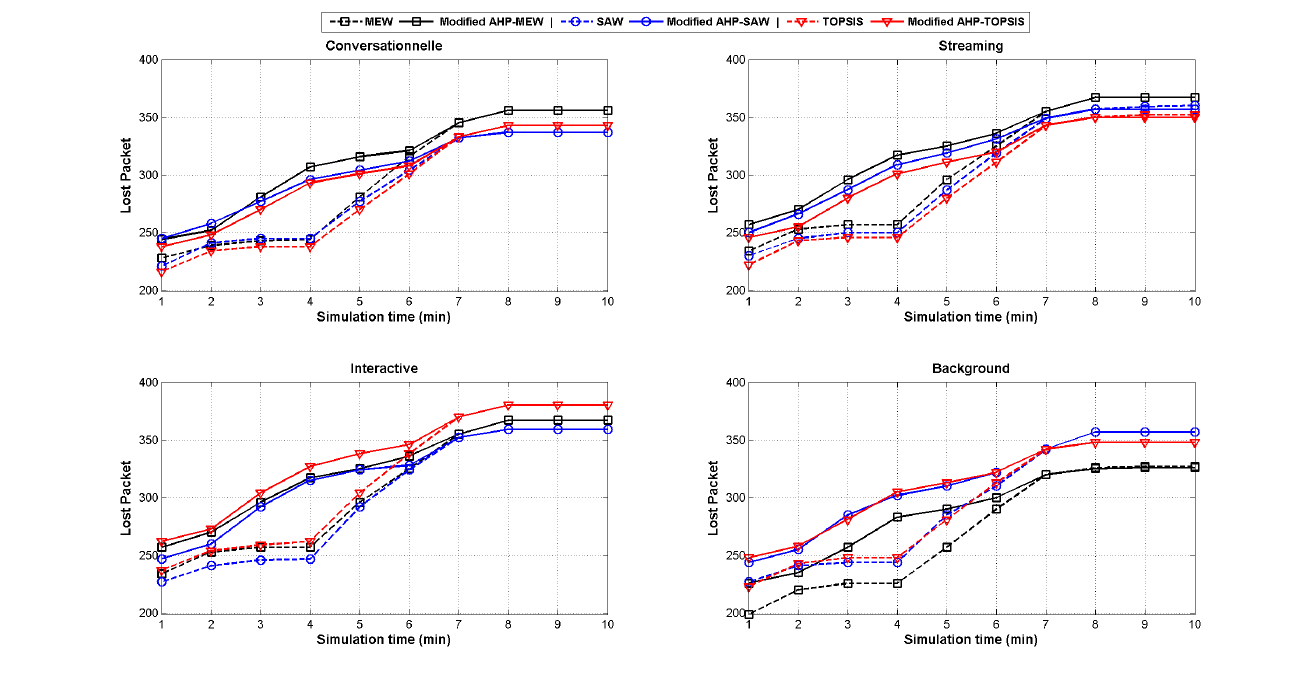
Figure 4. Behavior of Packet Loss over